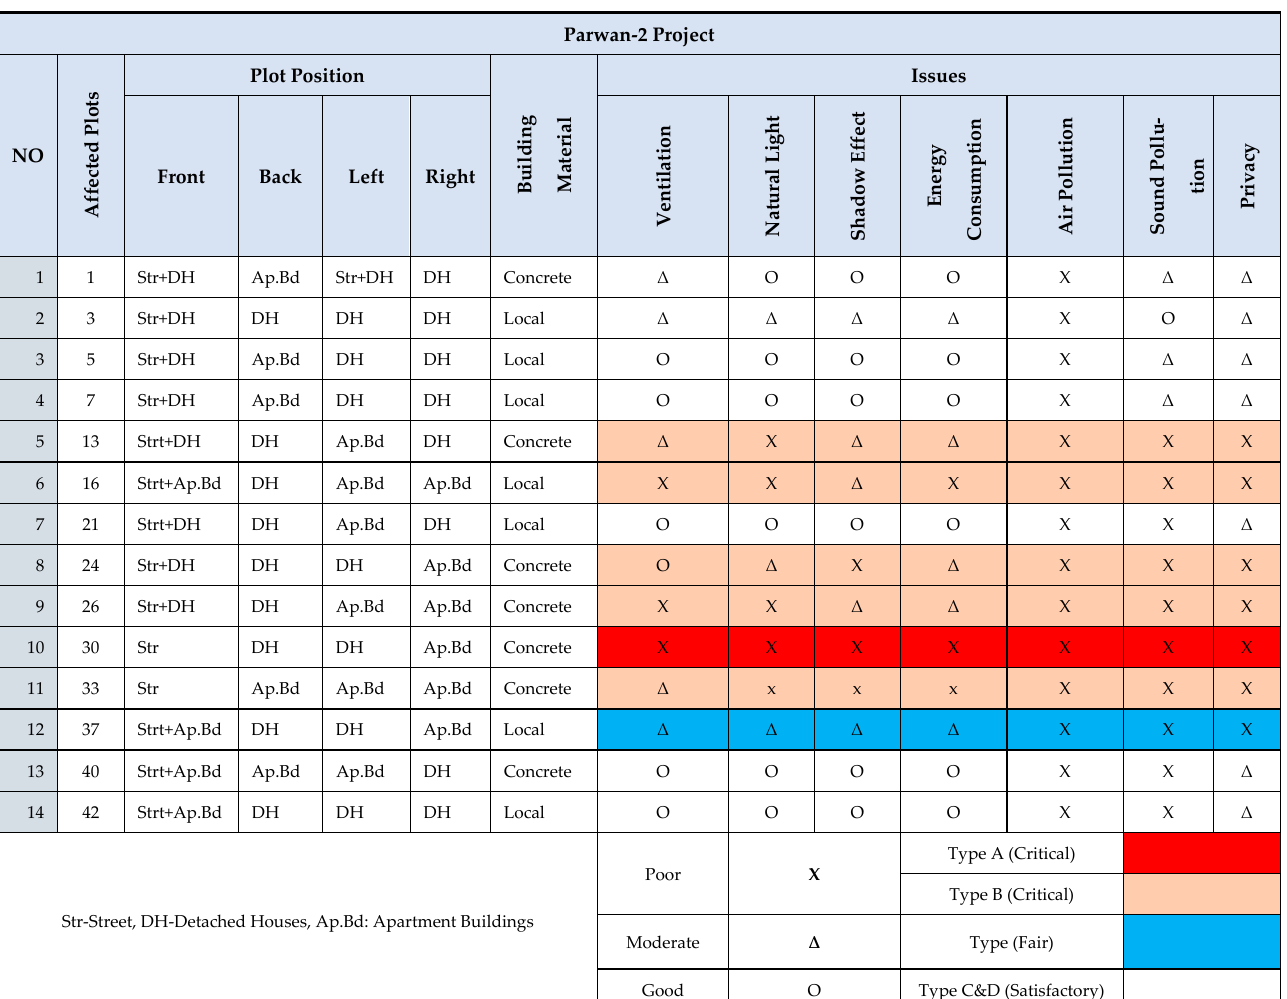
Table 12. Result of Parwan-2 Analysis.